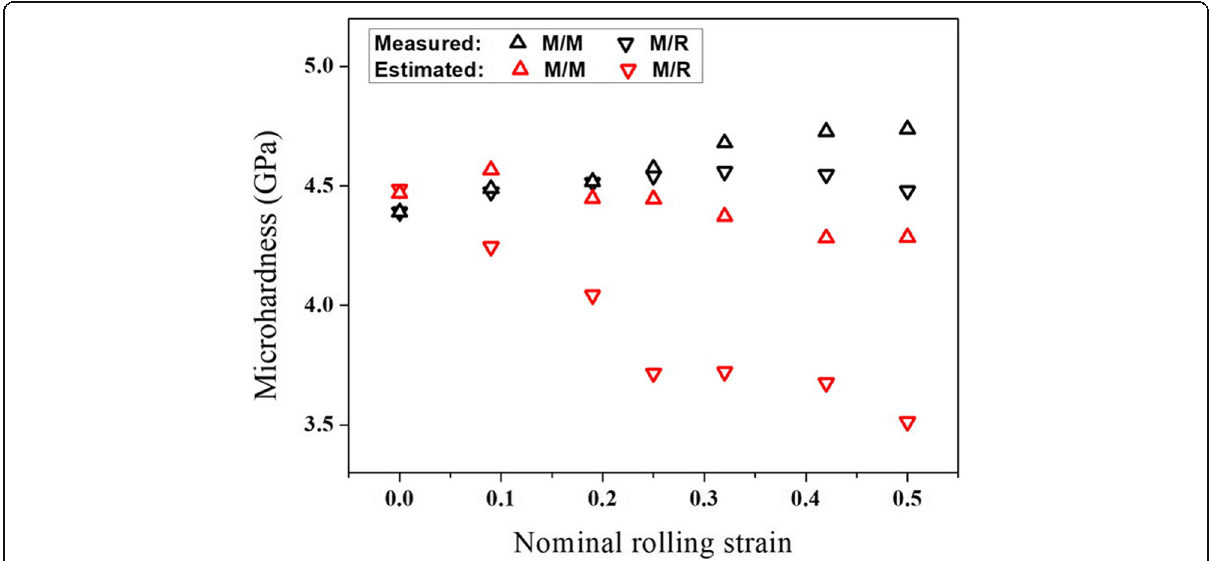
Fig. 4 Experimental measurement and estimated prediction of microhardness evolution during the pack rolling of pre-annealed nanocrystalline nickel. The estimated values of microhardness are determined only by the grain size and dislocation density on the basis of the Hall – Petch relationship and the Bailey – Hirsch